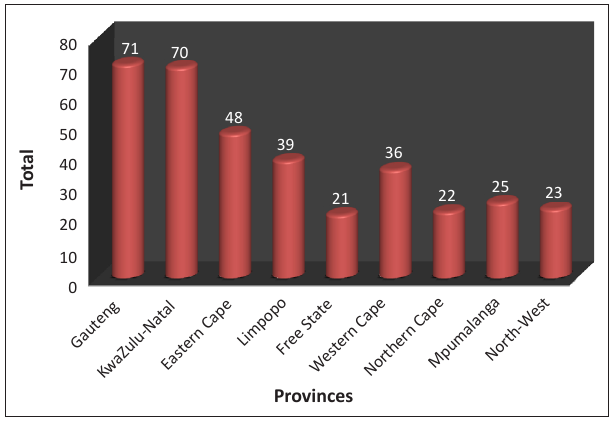
FIGURE 1: Location of respondents according to the nine provinces of South